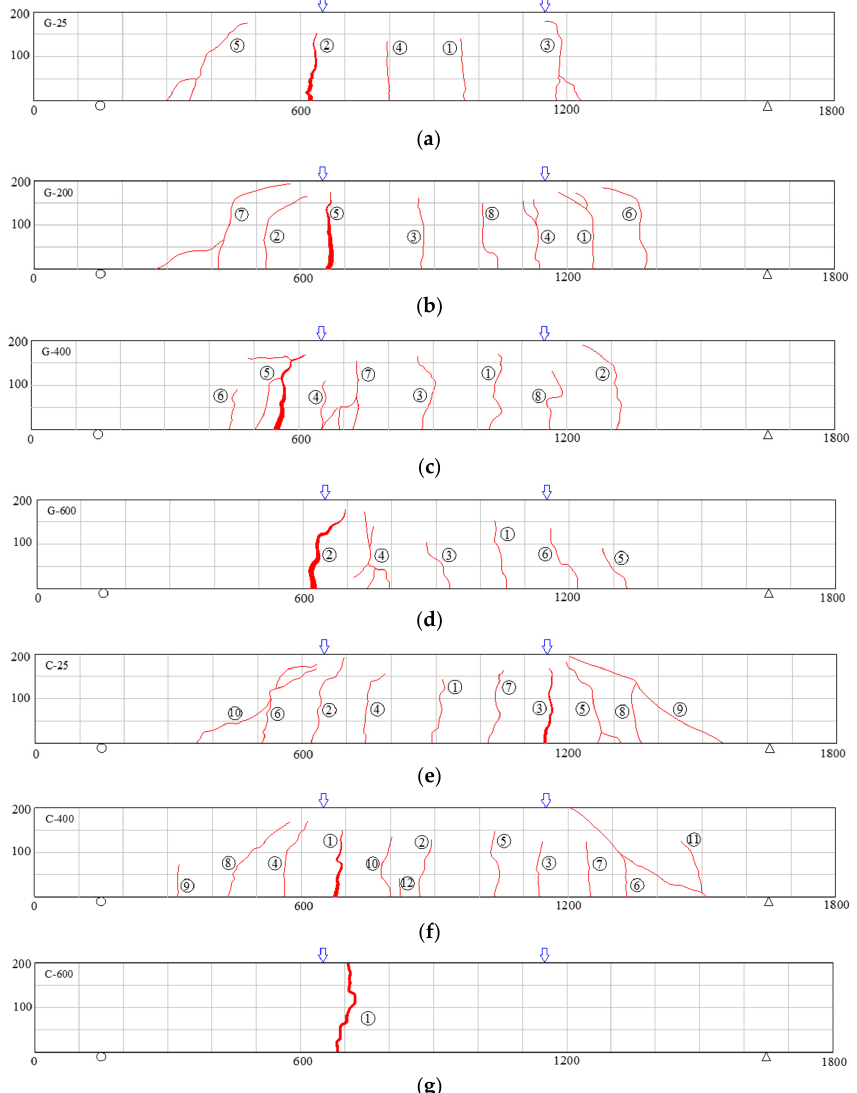
Figure 4. Crack distributions in all tested beams when fail (note: the figure in the circle represents the occurrence sequence of cracks, the arrows above the beam represent the loading points): ( a ) G-25; ( b ) G-200; ( c ) G-400; ( d ) G-600; ( e ) C-25; ( f ) C-400; ( g ) C-600.